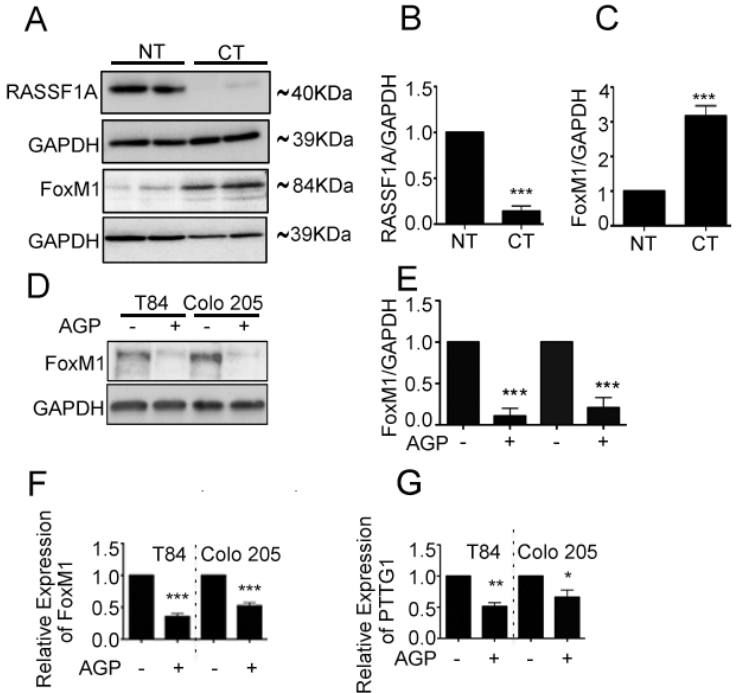
Figure 2. FoxM1 and RASSF1A expression is inversely co-related in colon cancer tissues. ( A ) Tissue extranction from both normal and colon cancer patient for monitoring the translational level of FoxM1 and RASSF1A by immunoblot. Quantification of RASSF1A ( B ) and FoxM1 ( C ) by scanning densitometry. GAPDH was used as a loading control. ( D ) T84 and Colo 205 cells were treated with or without AGP IC 50 (45 µ M) for 48 h. Cell lysates were analyzed by Western blot for FoxM1 and GAPDH expression. ( E ) Quantitative estimations of FoxM1 levels determined by densitometry measurements of western blots from three independent experiments after normalization with GAPDH ( p < 0.001). T84 and Colo 205 cells were treated with or without AGP as indicated before and the transcriptional level were determined by qRT-PCR for ( F ) FoxM1 and ( G ) PTTG1. Bar graphs show quantitative results normalized to GAPDH mRNA levels. Results are from three independent experiments and statistical significance was determined using one way-ANOVA followed Bonferroni test. (* p < 0.05, ** p < 0.01, *** p < 0.001).